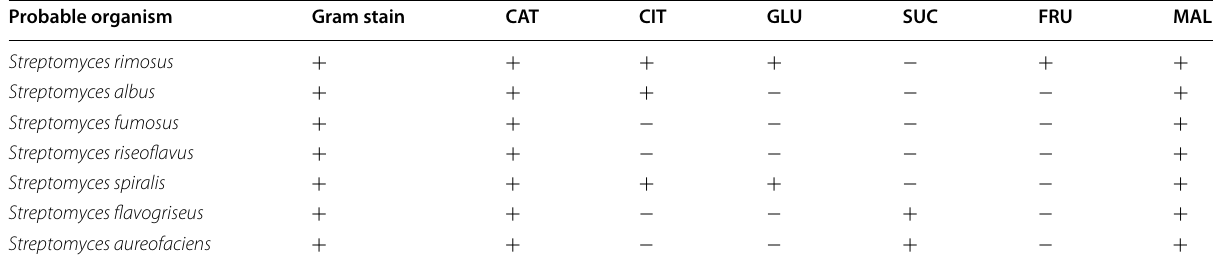
Table 3 Biochemical characteristics of the Streptomyces species isolated from grassland soils sample collected in Obanla, FUTA Probable organism